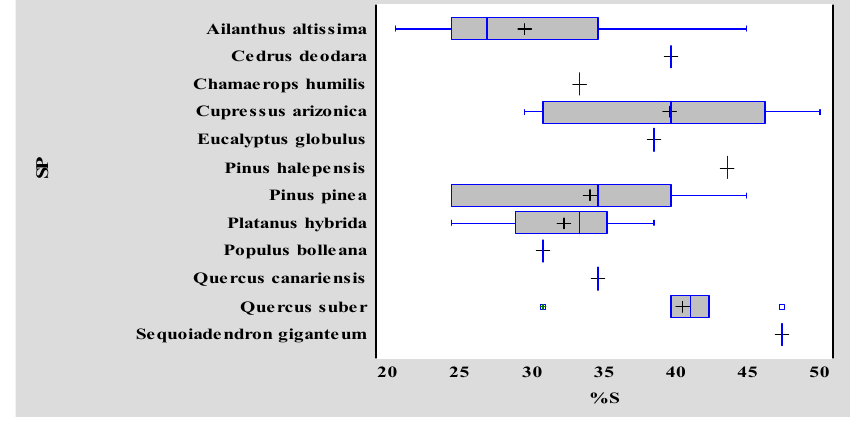
Figure 6. Box chart for %S according to species.